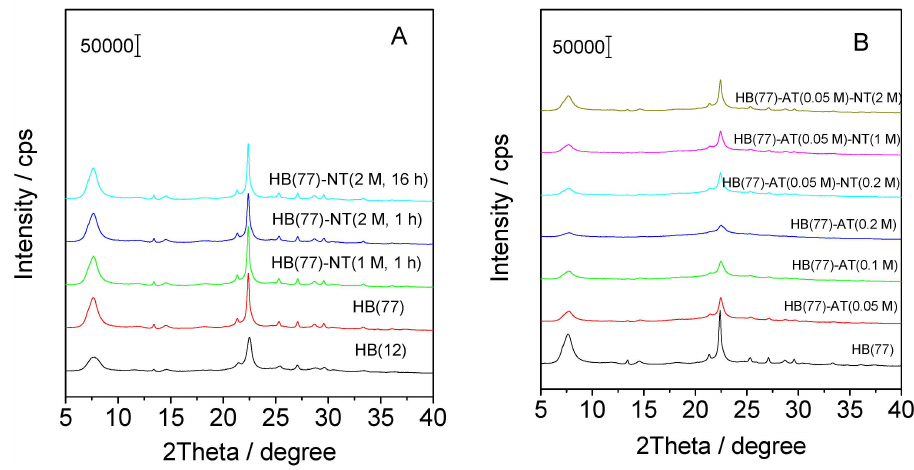
Figure 1. XRD patterns of HB(12), HB(77), acid-treated HB ( A ); alkali-treated and alkali-acid-treated HB ( B )